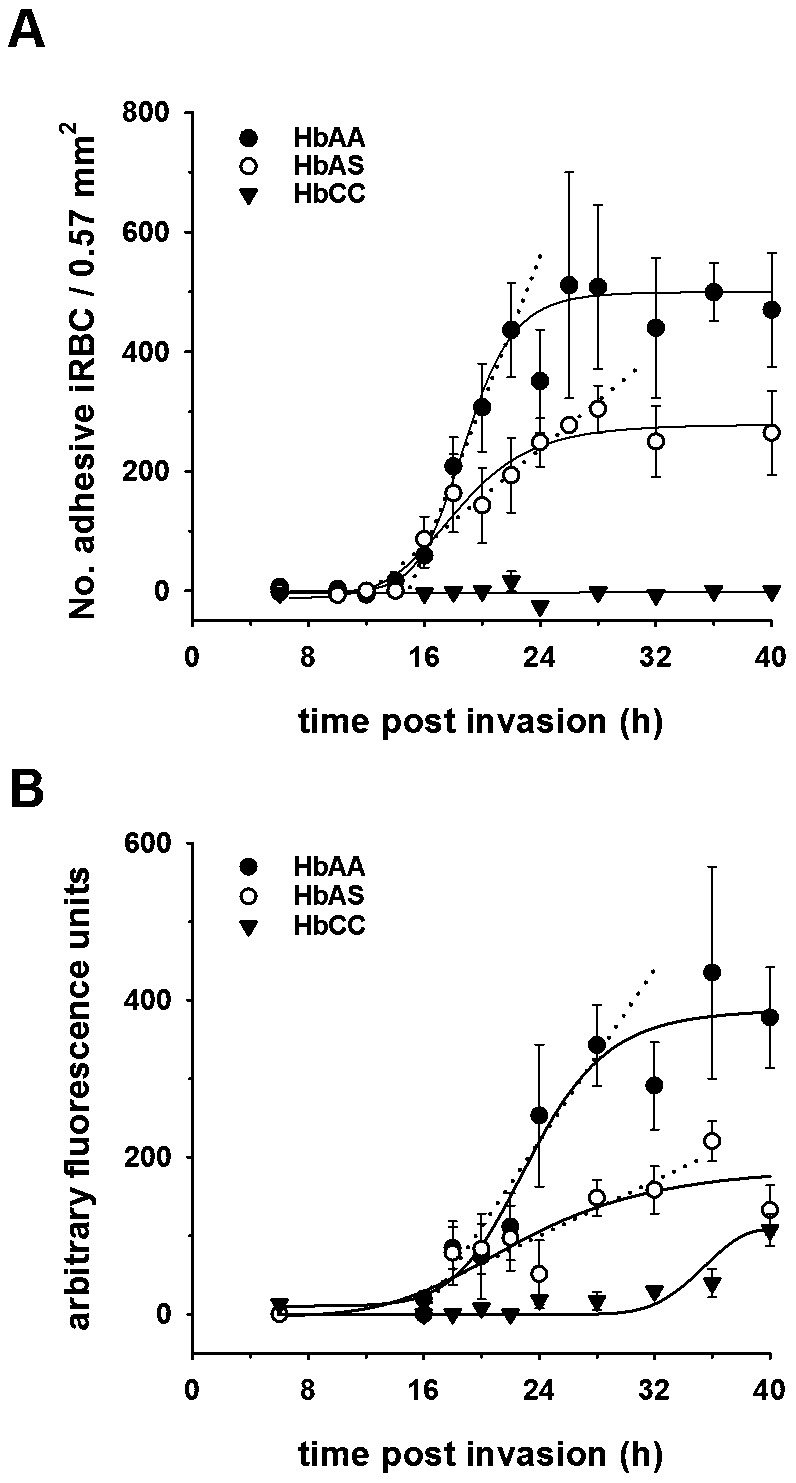
CSA-Adhesion and surface antigen presentation during the intraerythrocytic life cycle of P. falciparum in infected wild type and hemoglobinopathic erythrocytes.(A) Parallel adhesion assays were performed on tightly synchronized FCR3CSA at specified time points (6–40 h post invasion) during the intraerythrocytic life cycle. 5×106 cells were investigated in each experiment. The number of CSA-adhesive parasitized erythrocytes per field of view (0.57 mm2) was quantified by image analysis. Each data point is an average of at least three independent experiments±standard error of mean. Sigmoidal functions were fitted to each data set and the kinetics of adherence was quantified by fitting linear functions to the rising sections of each data set. (B) The temporal appearance of total antigens on the surface of parasitized HbAA, HbAS, and HbCC erythrocytes during the intraerythrocytic life cycle, as quantified by flow cytometry. Pooled sera from residents of a malaria holoendemic region in Burkina Faso were used for detection of parasitic surface antigens. Each data point is an average of at least three independent experiments±standard error of mean. The slopes of the linear parts of the data points were fitted to linear functions to quantify the kinetics of surface antigen presentation.